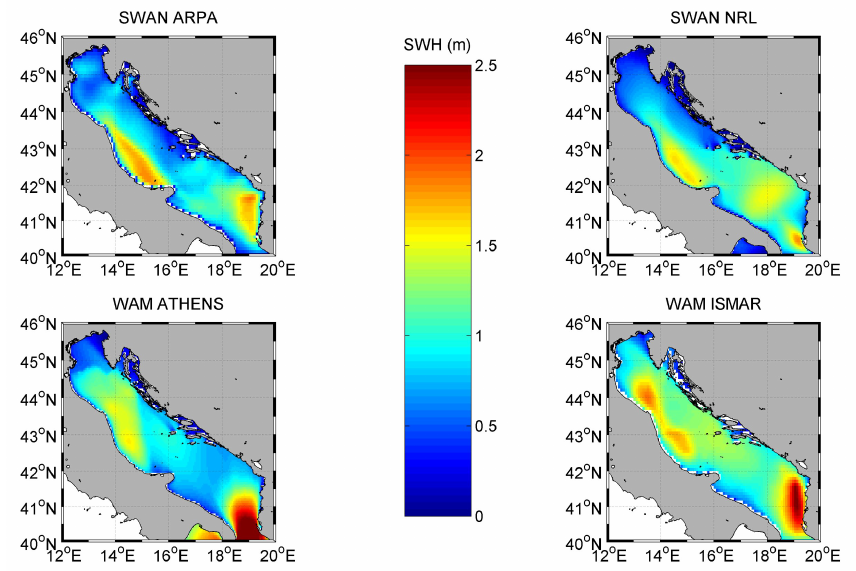
Fig. 2. Wave forecasts for 23 March 2006 at 00:00UTC in the Adriatic Sea.